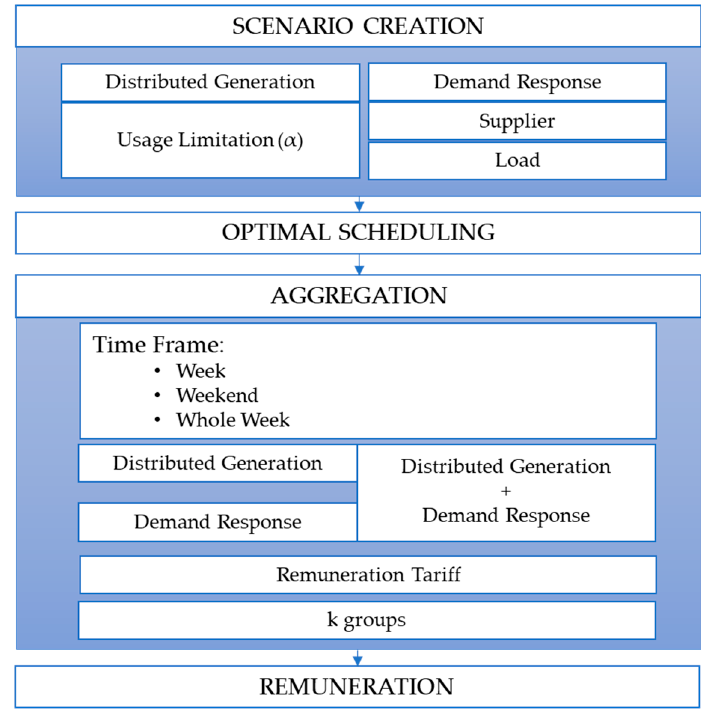
Figure 1. Overall definition of proposed methodology.